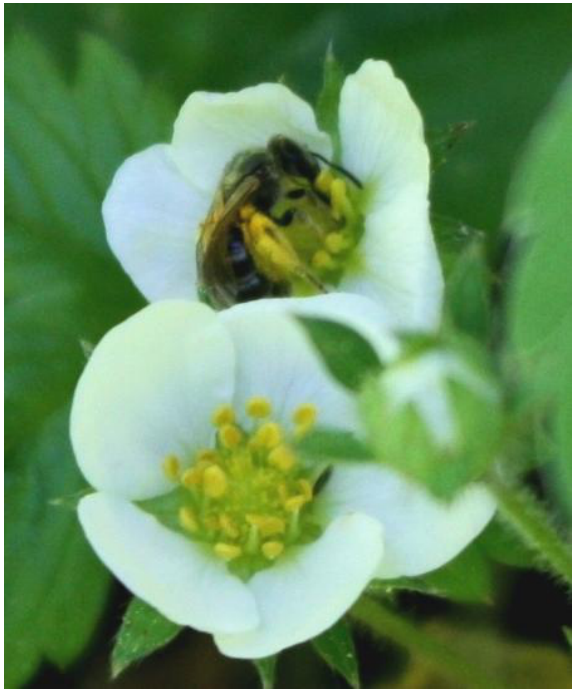
Figure 5. Unidentified bee foraging in flower of F. vesca after it exited a flower of C. montanum approximately two meters away. Note the smear on the dorsum of the thorax (Photograph by Nan